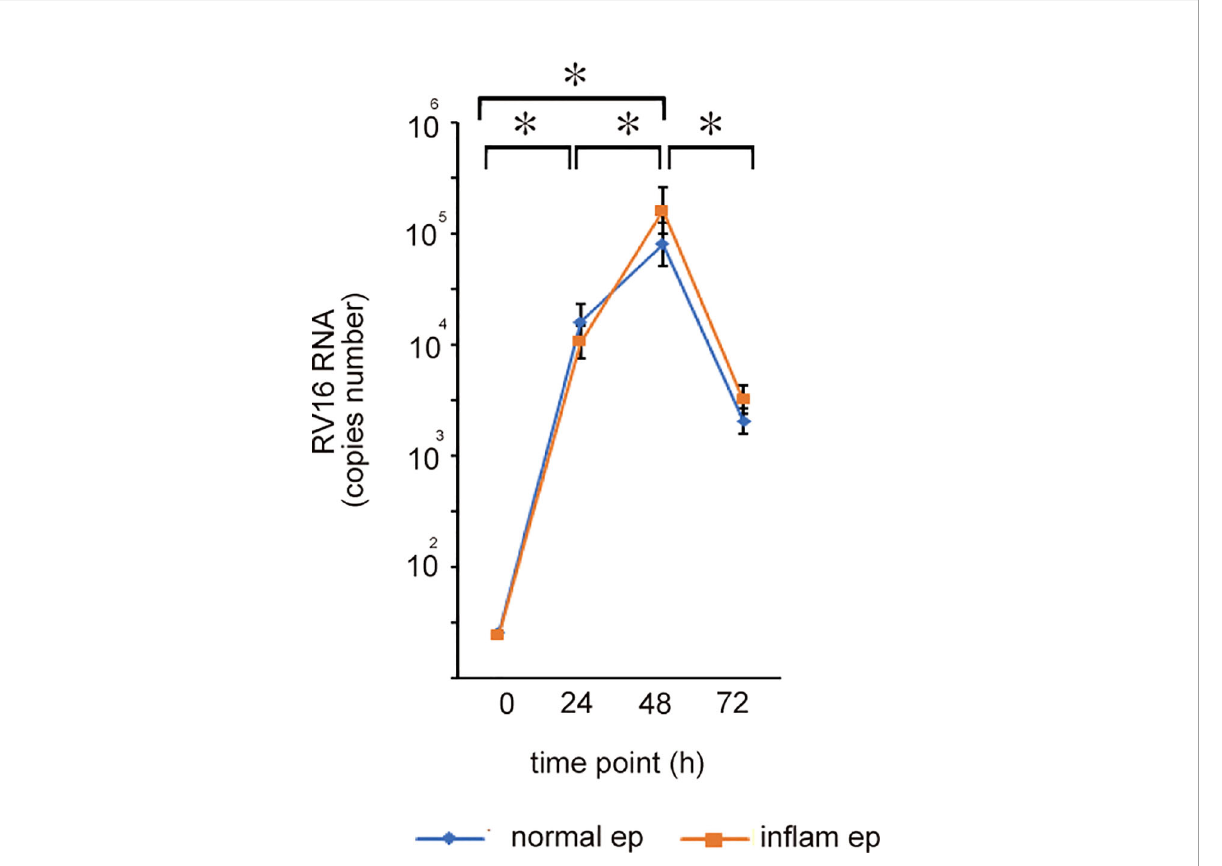
FIGURE 1 Normal and in fl ammatory sinonasal epithelial cells obtained from healthy control (N=7) and patients with CRSwNP (n=7) respectively were cultured in ALI which was infected with rhinovirus (RV)16 at MOI of 0.5. RV replication rates were assessed by RT-qPCR 24, 48, and 72 h after RV 16 inoculation and expressed as total copy number. The copy number of RV 16; normal epithelium; 24 h: 1.1 x 10 4 – 5 x 10 4 , 48 h: 8.5 x 10 4 – 1.1 x 10 5 , 72 h: 3.4 x 10 3 – 4.2 x 10 3 , in fl ammatory epithelium: 24 hr: 0.92 x 10 4 – 3.3 x 10 4 , 48 hr: 9.5 x 10 4 – 3.2 x 10 5 , 72 hr: 3.7 x 10 3 – 4.6 x 10 3 ). *indicates a signi fi cant difference between each